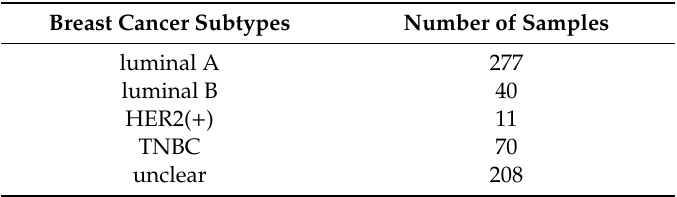
Table 3. The numbers of distinct breast cancer